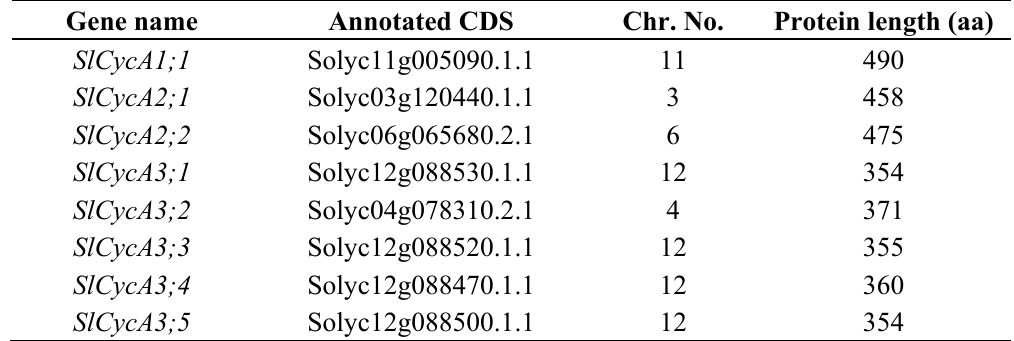
Table 1. List of cyclin genes identified in tomato. Predicted genes and related information include sequenced ID, chromosome locations and protein